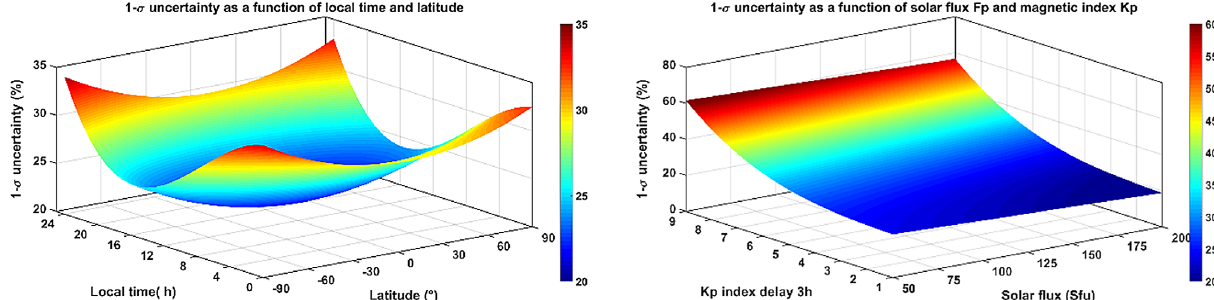
Fig. 10. 3D surface plot of the 1- r uncertainty (in percent) (top-left) altitude and latitude, (left) geographical coordinates; (right) solar proxy and magnetic index.